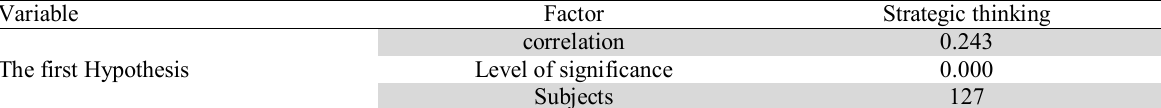
The results of Pearson correlation for the first hypothesis (Interpersonal intelligence) Variable Factor Strategic thinking The first